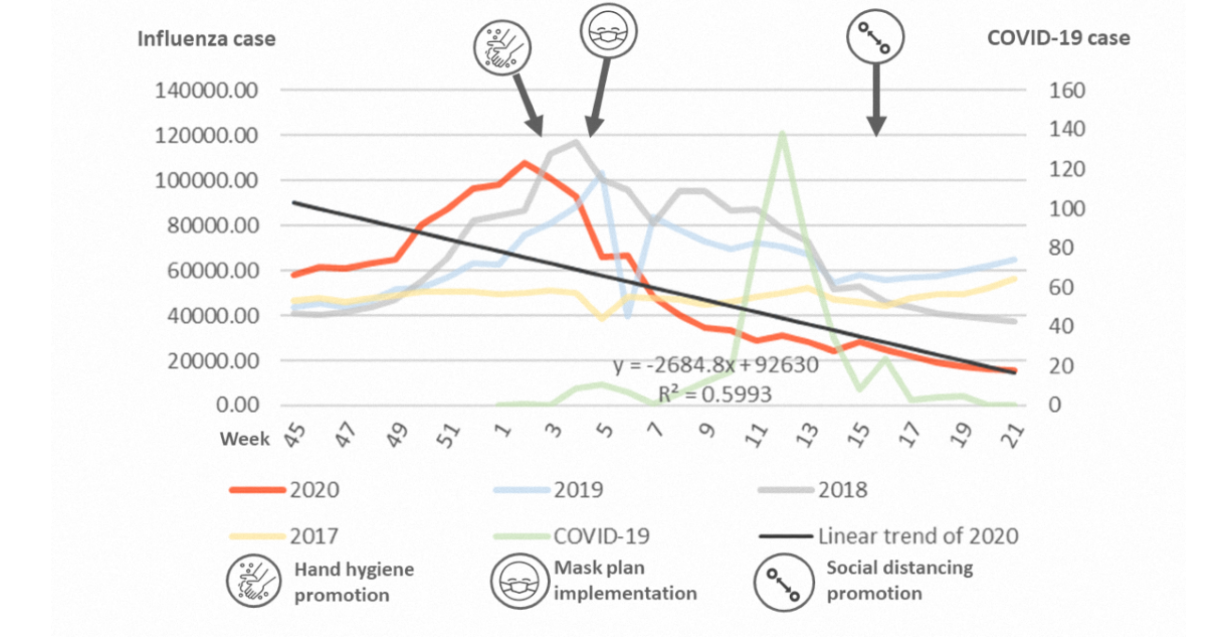
Figure 2. Incidences of influenza in 2017-2020. COVID-19: coronavirus